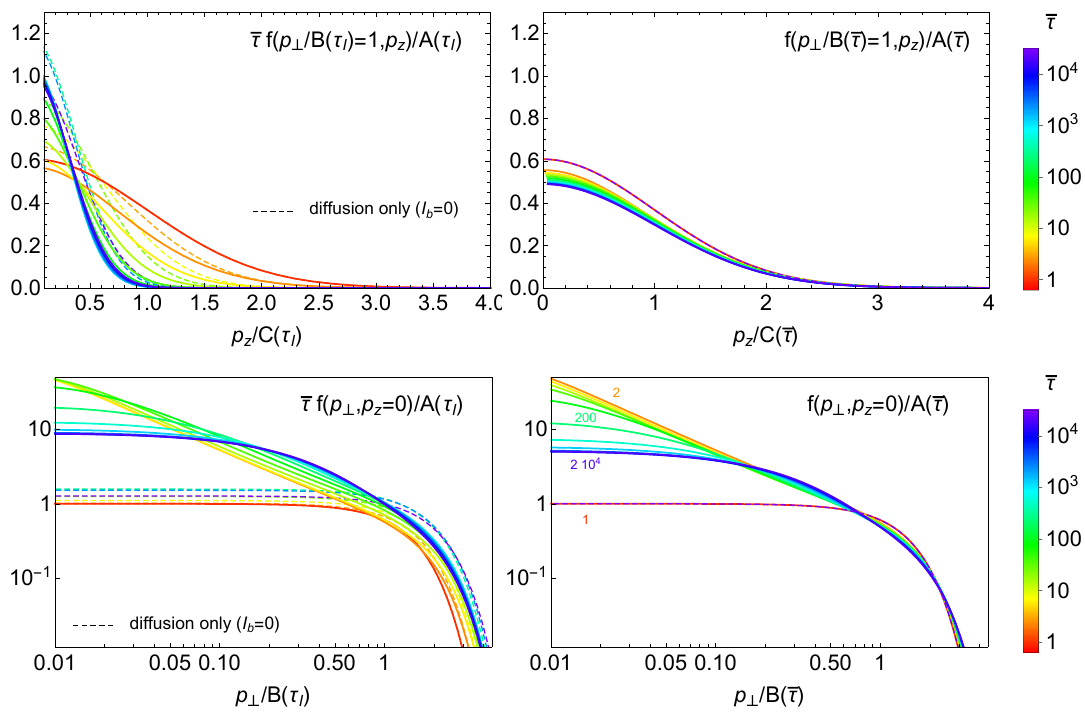
Figure 4 . The same as figure 3 but for ( g s , σ 0 ) = (0 . 1 , 0 . 6) . Note in the left figures we use A, B, C determined not by BMSS but dilute fixed point exponents